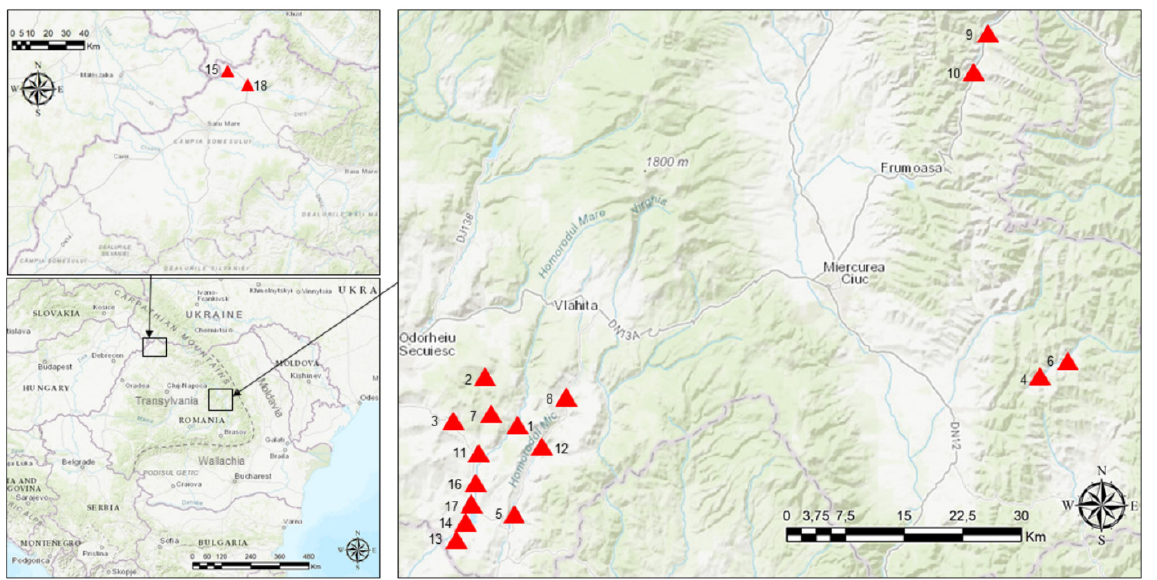
Figure 4. The study area in Transylvania (Romania) . Numbers refer to the studied villages: (1) Aldea, (2) C ă lug ă reni, (3) Chinu ș u, (4) Cinod, (5) Cr ă ciunel, (6) Egershec, (7) Ghipe ș , (8) Lueta, (9) (2) C ă lug ă reni, (3) Chinus u, (4) Cinod, (5) Cr ă ciunel, (6) Egershec, (7) Ghipes , (8) Lueta, (9) Lunca , , Lunca de Jos, (10) Lunca de Sus, (11) Martini ş , (12) Mere ş ti, (13) Or ăș eni, (14) Petreni, (15) de Jos, (10) Lunca de Sus, (11) Martini¸s, (12) Mere¸sti, (13) Or ă s eni, (14) Petreni, (15) , Porumbe ş ti, (16) Rare ș , (17) Sânpaul, and (18) Turulung.